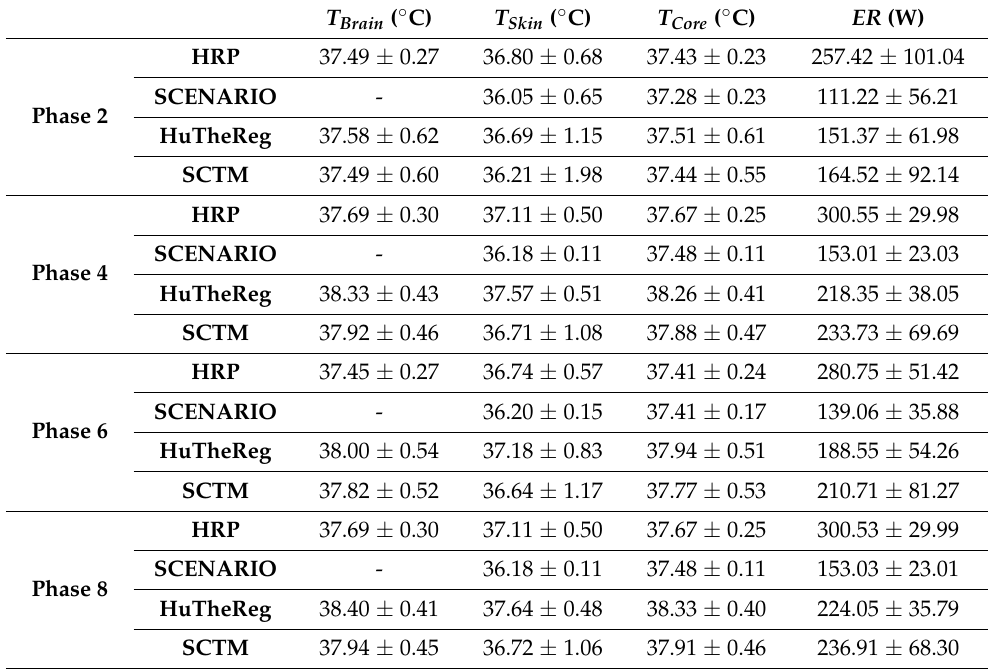
Table 4. Mean and standard deviation values for moderate working profile G_12.